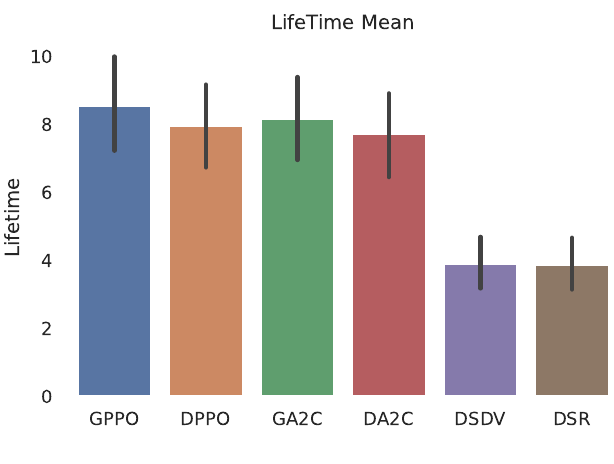
Figure 4. Path life time.